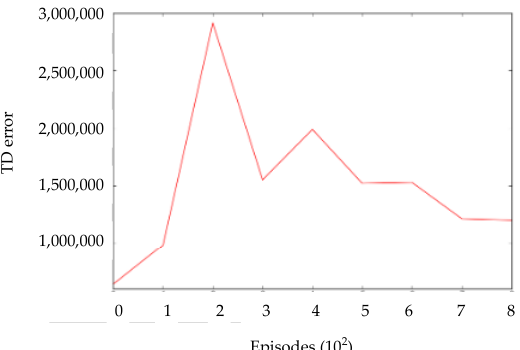
Figure 16. Average cumulative TD error of a DDQN agent in the Gazebo simulator.